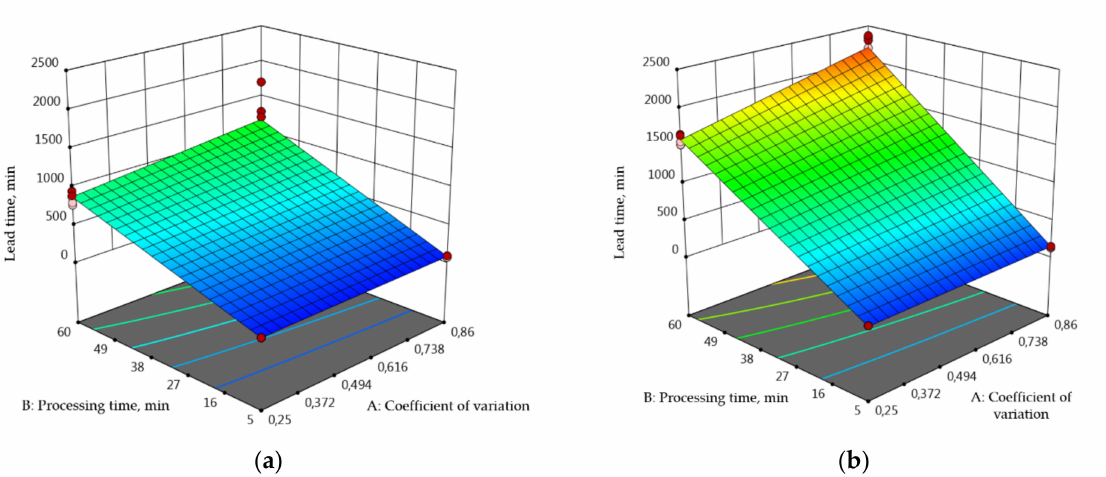
Figure 5. Response surface 3D plots: ( a ) Effects of coefficient of variation and operation time on lead time for the process with bottleneck and two Kanban cards in each operation; ( b ) Effects of coefficient of variation and operation time on lead time for the process with bottleneck and five Kanban cards in each